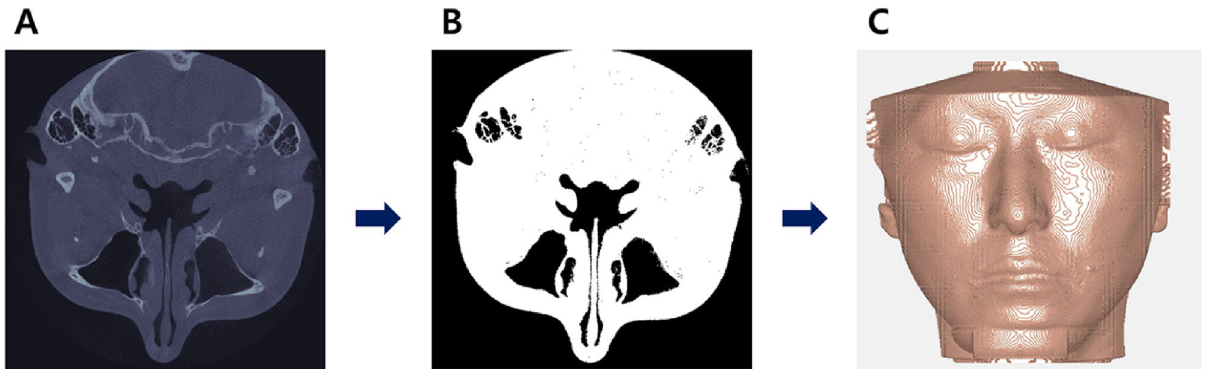
Figure 1. Image processing sequence. ( A ) Axial view of cone-beam computed tomography image. Hard tissues appear white, and soft tissues appear black or gray. ( B ) Automatic binarization using the Otsu method. Soft tissue images appear white. ( C ) Surface reconstruction using the marching cube algorithm. Contour lines are